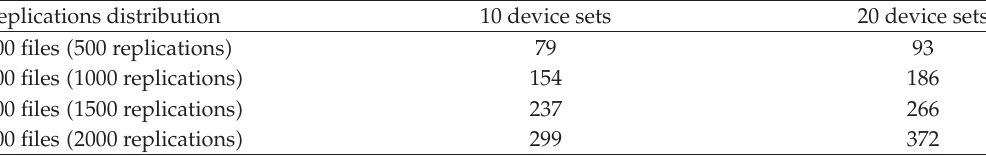
Table 1: Distribution situation of replications.